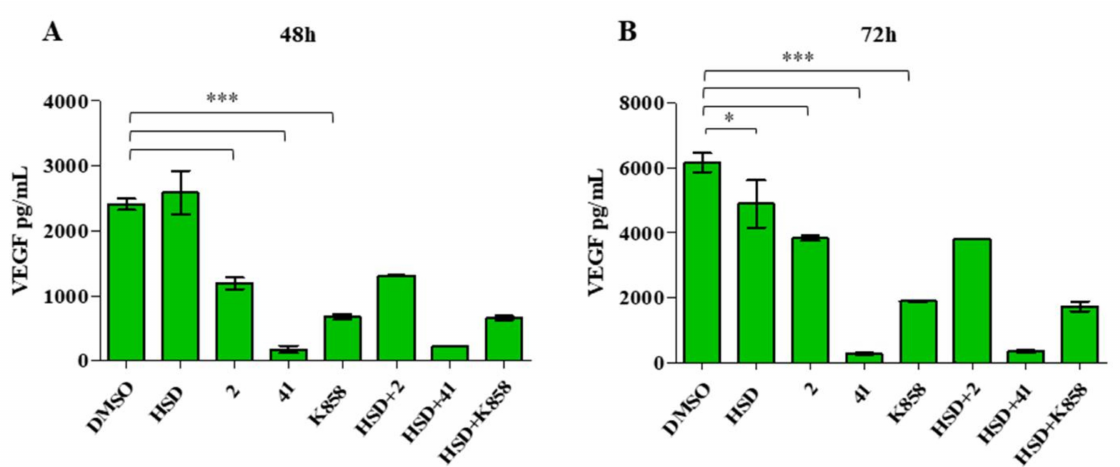
Figure 8. ELISA assay of AGS VEGF secretion. Cells were treated with HSD (180 µ M), 2 (1 µ M), 41 (5 µ M), K858 (1 µ M), and a combination of HSD with each Eg5 inhibitor for 48 ( A ) and 72 h ( B ). Secretion levels are reported as pg/mL. The results are the mean ± SD of three samples from three different experiments. *** p < 0.0001; * p < 0.01.